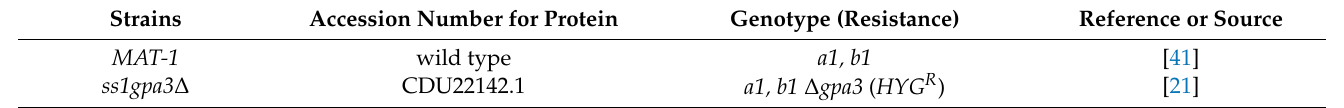
Table 1. Details of strains shown in this